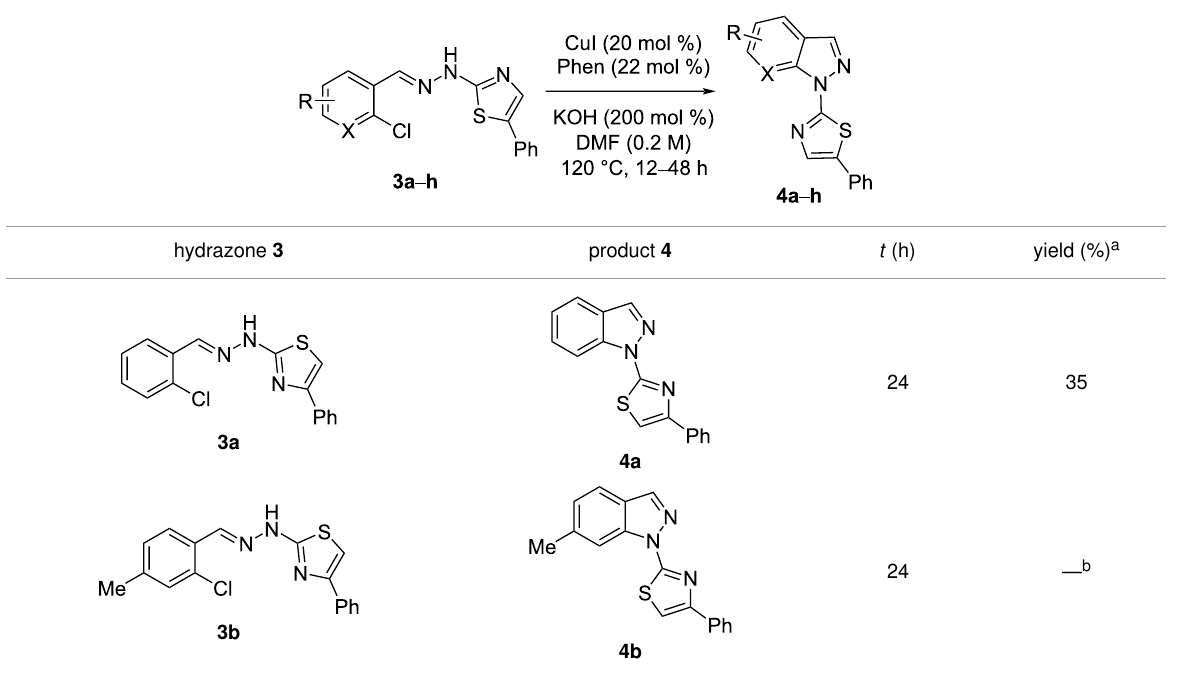
a Isolated yield. b Product not obtained.